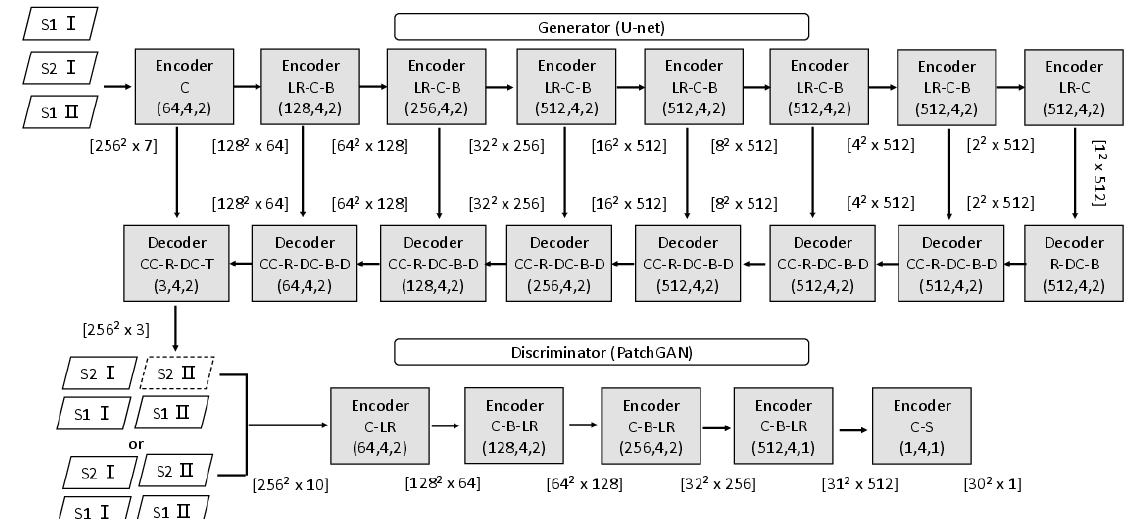
Figure 5. Structure of the Generator and Discriminator (C: Convolution, LR: Leaky ReLU, B: Batch Normalization, R: ReLU, DC: Deconvolution, CC: Concatenation, D: Dropout, T: Tanh, S: Sigmoid. The three numbers in the parentheses denote the number of filters, filter size, and stride, respectively. The numbers in the brackets indicate the size and the number of features of the